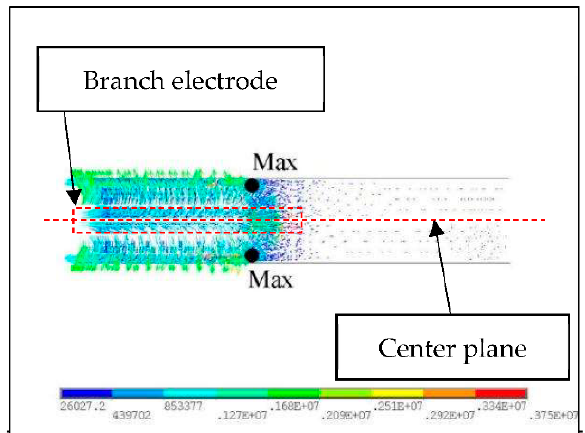
Figure 8. The electric field of the partial model.